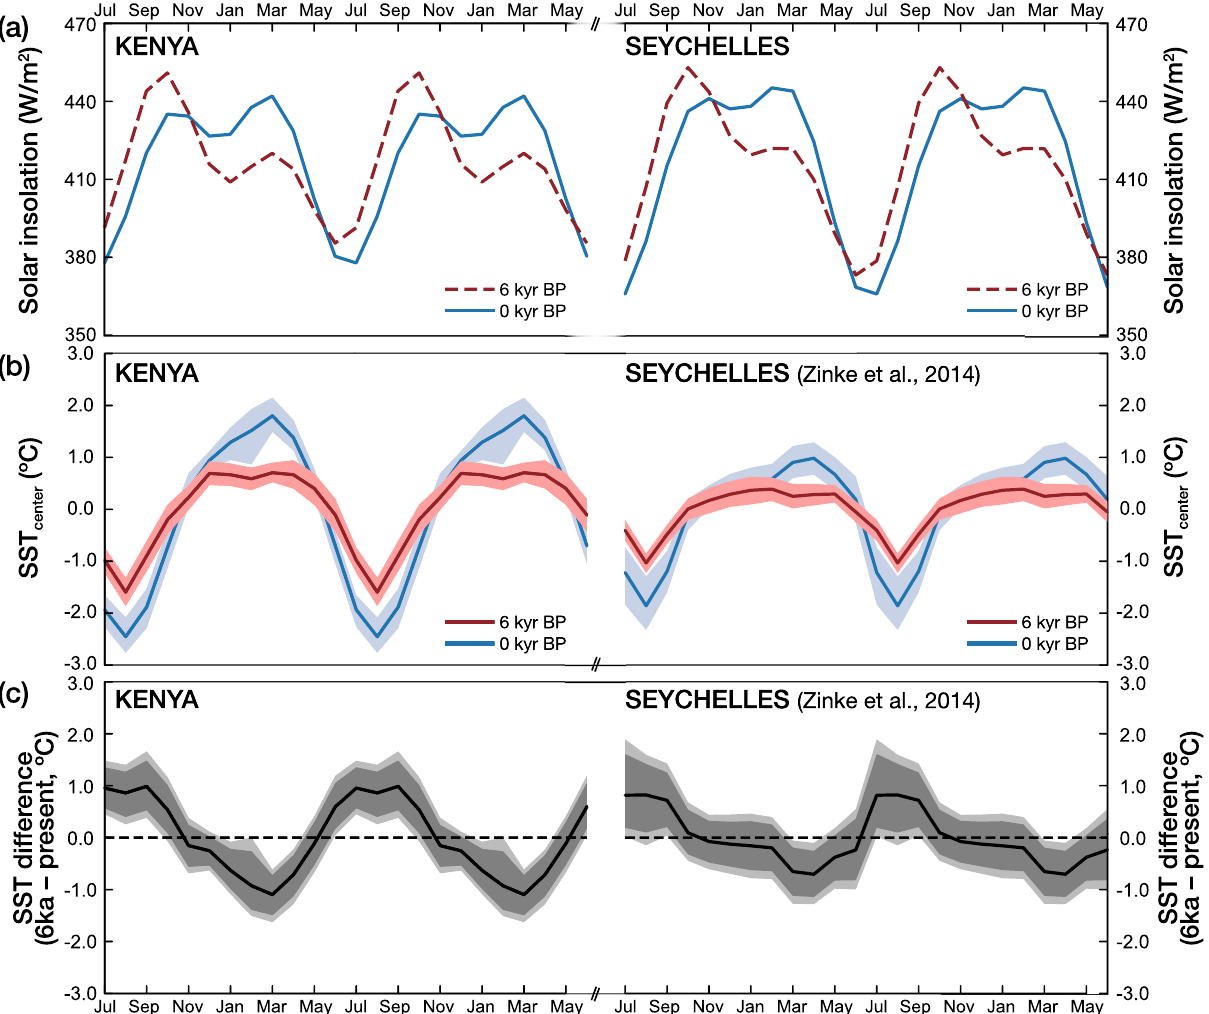
Figure 4. Insolation at the top of the atmosphere 28 and mean seasonal SST cycles calculated from coral Sr/Ca. ( a ) Insolation at 6 ka BP (red dashed lines) and 0 ka BP (solid blue lines) for Kenya and Seychelles ( b ) mean annual SST cycles inferred from the mid-Holocene corals (red) and the modern corals (blue) from Kenya (left; this study) and the Seychelles (right, data from 17 . Colored shades are the 90% confidence intervals of mean SSTs in each month (see “Methods” for details). ( c ) Difference of mean seasonal SST cycles between the mid-Holocene and modern corals from Kenya (left; this study) and Seychelles (right, data from 17 ). Dark and light grey shading indicates the 99 and 95% confidence level of the SST difference, respectively. Note that the SST difference was calculated from centered data, so negative (positive) SST differences do not indicate colder (warmer) absolute SSTs. Differences in mean seasonal cycles are significant when the confidence level of the SST difference is beyond the zero